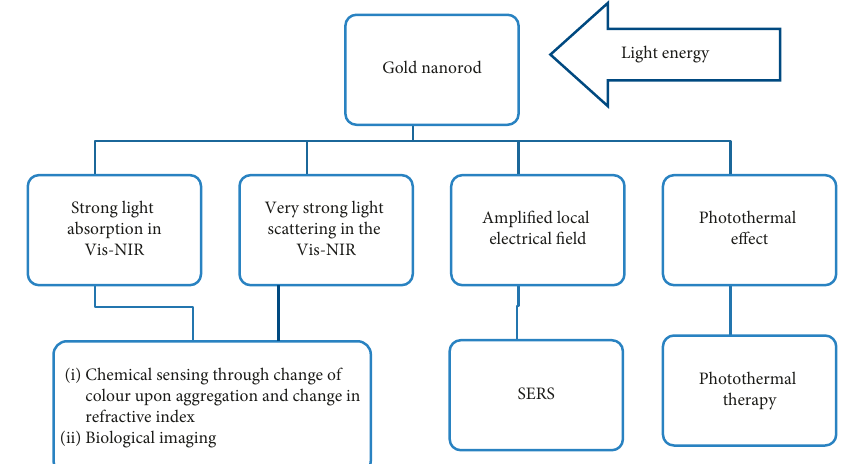
Figure 21: AuNRs effects and applications [290].